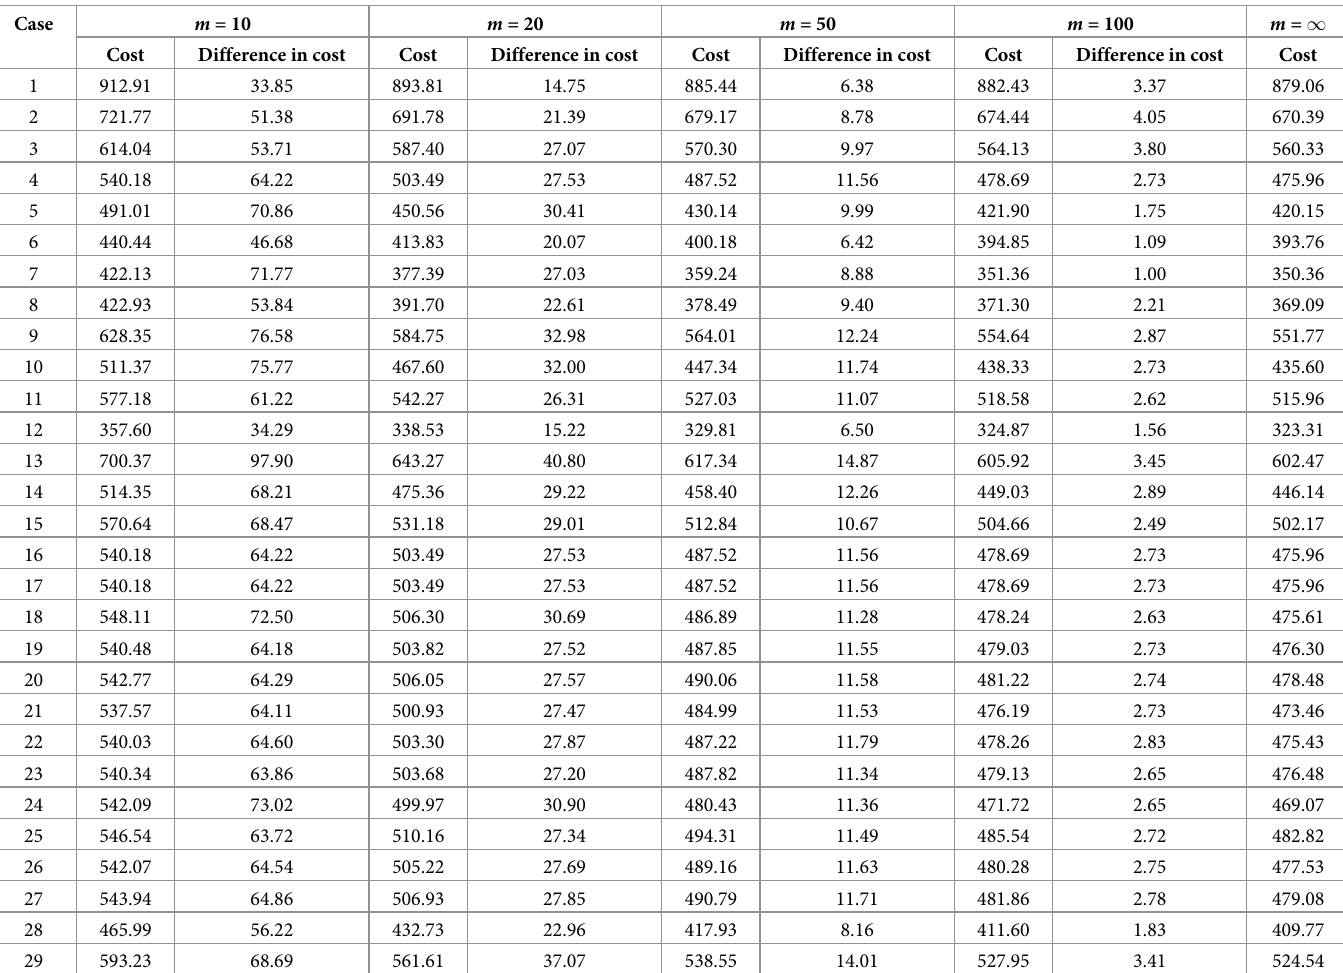
Table 3. Expected cost of the synthetic np chart with estimated process parameter corresponding to the optimal chart parameters of the known process parameter